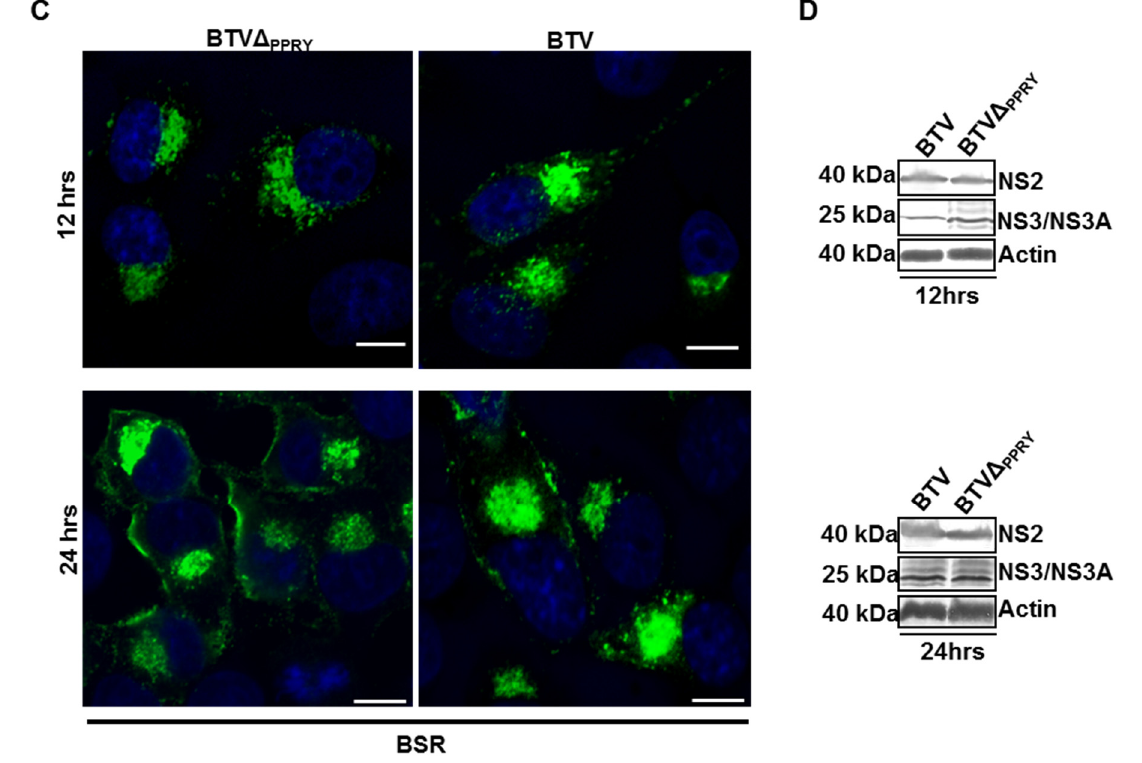
Figure 7. Effect of PPRY domain mutation on NS3 distribution. Localization ( A , C ) and expression ( B , D ) of NS3 in ( A , B ) PT and ( C , D ) BSR cells infected with BTV Δ PPRY or WT BTV1. NS3 was visualized in green and nucleus has been labelled with Hoechst (blue). Scale included in each panel represents 20 µm. The expression of NS2, NS3 and actin in infected ( B ) PT and ( D ) BSR cells were analysed at 12 and 24 h pi. Lysates were analyzed by SDS-PAGE and Western blotting. Molecular masses and virus proteins are indicated on left and right,